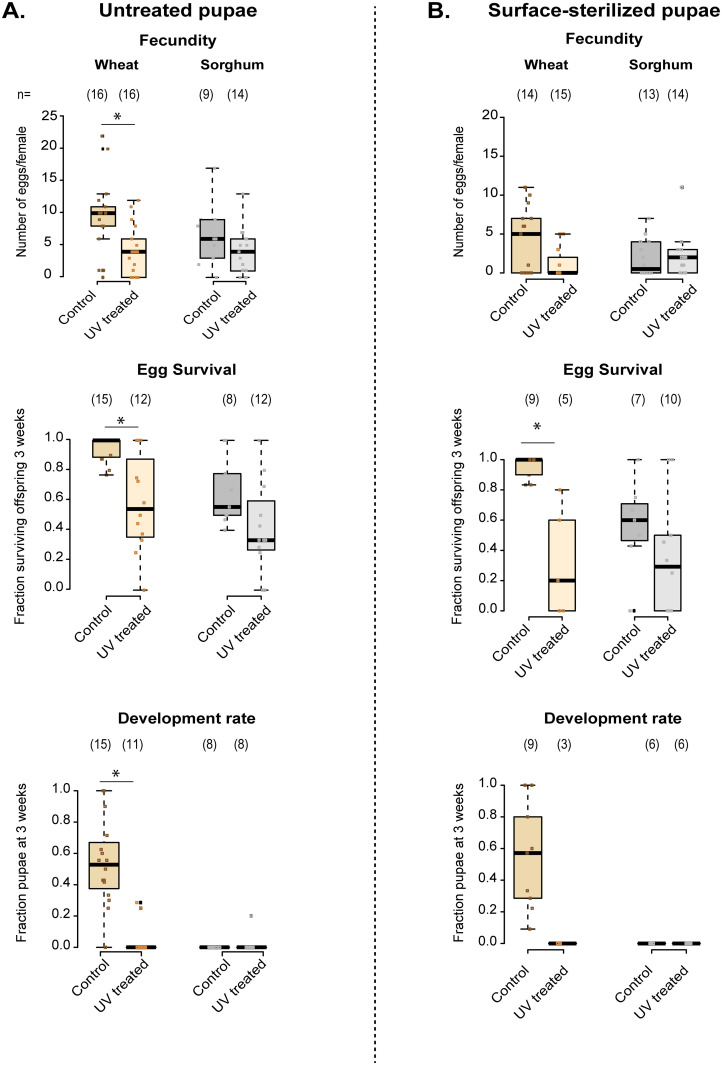
Effects of pupal surface sterilization and UV treatment of flour on fecundity, survival, and development rate.Fecundity, offspring survival and offspring development rate in untreated (“control”) vs. UV-treated wheat and sorghum, measured for adults obtained from (A) untreated and (B) surface-sterilized pupae. Boxplots show median values per female (boxes indicate interquartile length (IQL); whiskers indicate 1.5x IQL), with overlaid raw data (each point indicates data for a single female). Asterisks indicate a significant difference between control and UV treatment, based on pairwise comparisons using a generalized linear model (for full analysis with ANOVA or GLM, see S1 Table). Sample sizes are indicated in parentheses above each box. The sample sizes for offspring survival are lower because some females did not lay any eggs. Similarly, sample sizes for development rate are reduced further because replicates with no surviving offspring were removed.